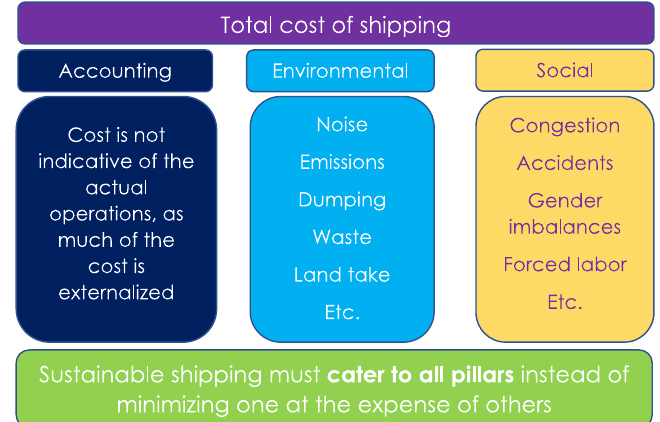
Fig. 10 The total cost framework (source: